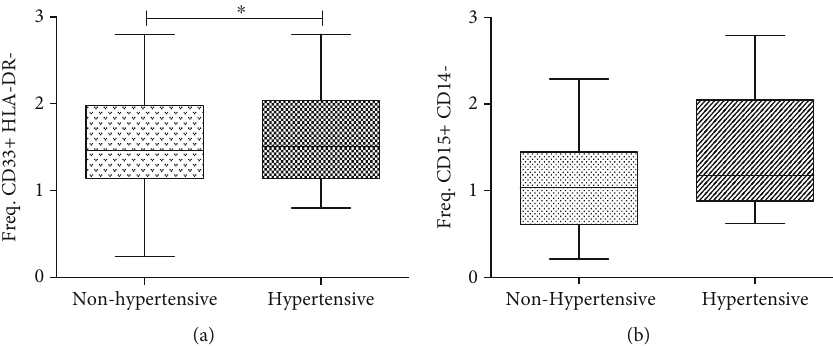
Figure 3: Frequency of CD33+ HLA-DR-/low and CD15+ CD14- MDSCs comparing if the subjects have hypertension in both groups (DM2 and non-DM2). (a) Frequency of CD33+ HLA-DR-/low MDSCs (hypertensive n = 16 , nonhypertensive n = 27 ). (b) Frequency of CD15+ CD14- MDSCs (hypertensive n = 15 , nonhypertensive n = 26 ). The graphs show the median and interquartile ranges. It was considered as statistically signi fi cant if P value < 0.05 ∗ which was calculated using the statistical t -test for unpaired samples. Statistical analysis was performed with the GraphPad Prism® v5.0 software.